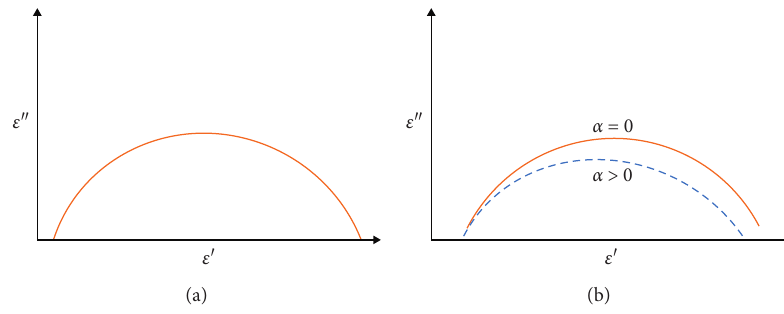
Figure 3: Illustration of (a) the Debye semicircle and (b) a Cole-Cole